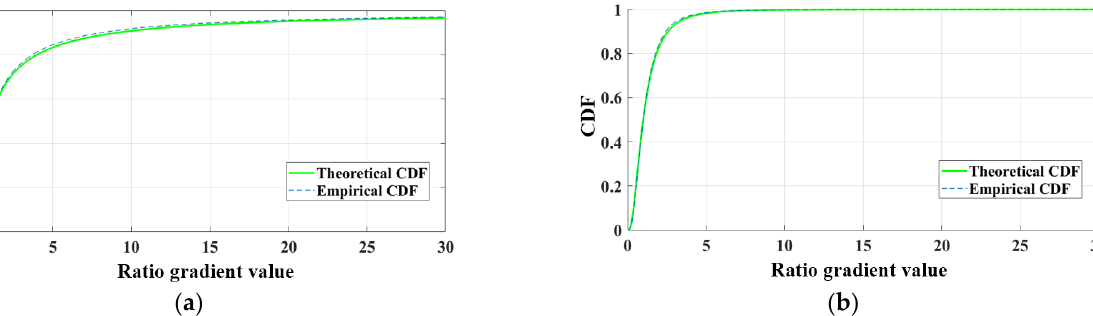
Figure 2. Theoretical and empirical CDF of the ratio gradient on single-look speckled homogeneous image. ( a ) The pixel based ratio gradient; ( b ) the patch based ratio gradient. image. ( a ) The pixel based ratio gradient; ( b ) the patch based ratio